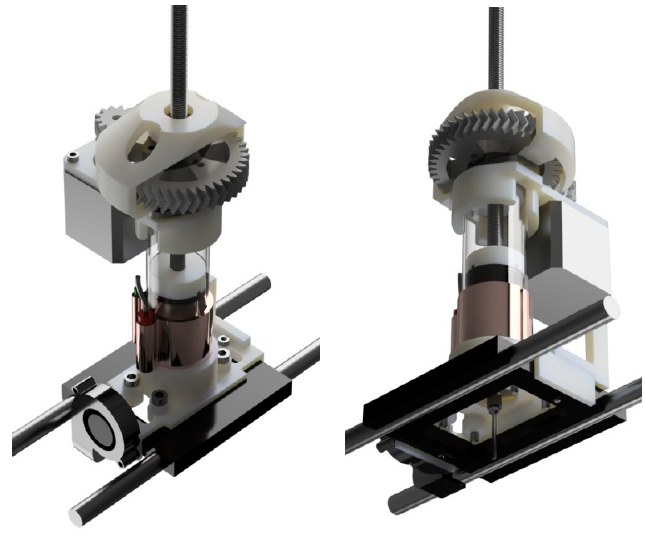
Figure 2. Isometric views of the developed paste extruder for material extrusion 3D printers.